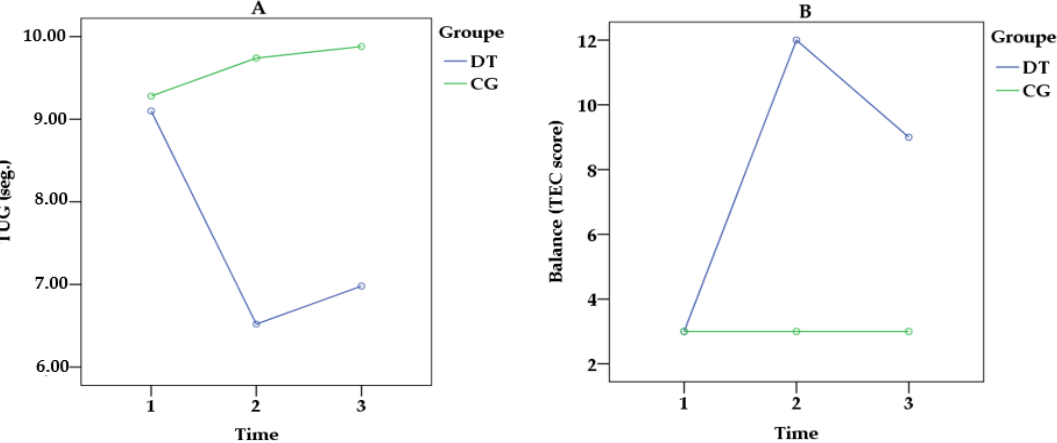
Figure 2. Results of the time × group interaction analysis, according to the groups. ( A ) Single gait performance by the TUG test; ( B ) performance of static and dynamic balance by the TEC test; seg. = seconds.